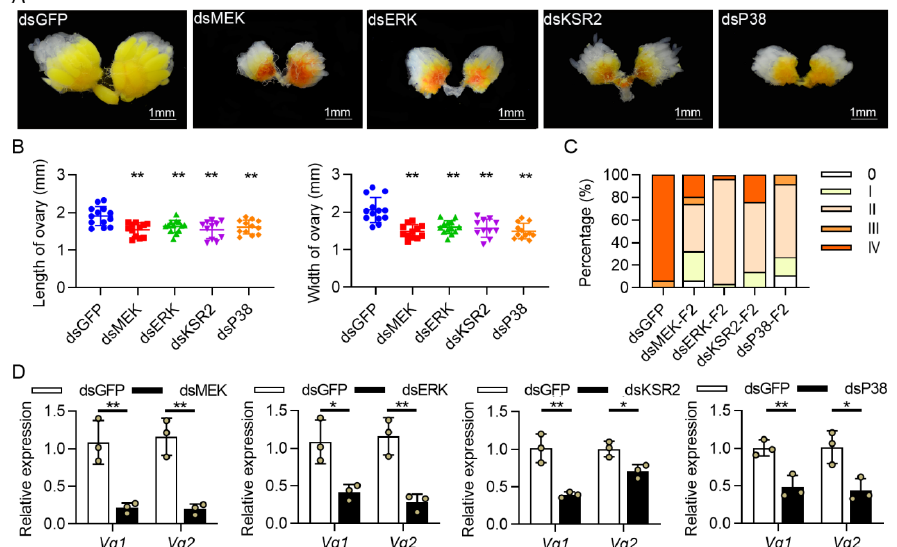
Figure 3. The effects of knocking down MEK , ERK , KSR2 , and P38 on female C. bowringi ovarian development. ( A ) Representative ovarian samples after dsRNA treatments. ( B ) Ovary sizes as a result of key gene silencing ( n = 11–13). ( C ) Ovarian development grades after treatment with second non-overlapping dsRNA fragments of key genes ( n = 18–32). ( D ) Vg1 and Vg2 expression levels were detected in the fat bodies. All data were collected at 4 days PE and presented as mean ± SD, with a significance test performed between the control and treatments using an independent t -test, * p < 0.05, ** p <